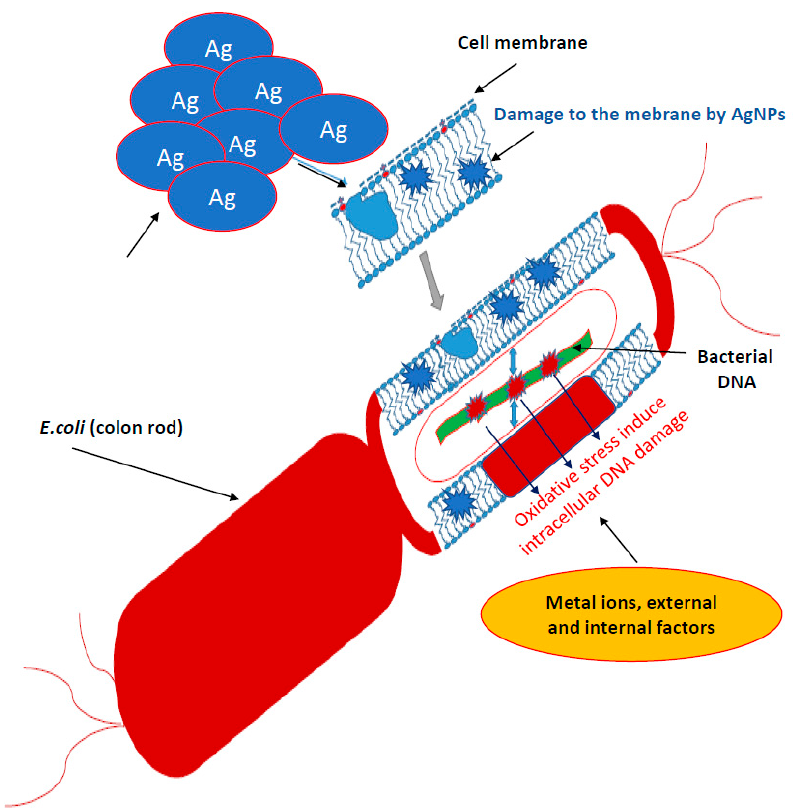
Figure 1. Mechanisms of silver nanoparticles action into bacterial cells. It is characterized by a lack of specificity and runs at a very high speed, causing oxidative stress that induces bacterial DNA damage.